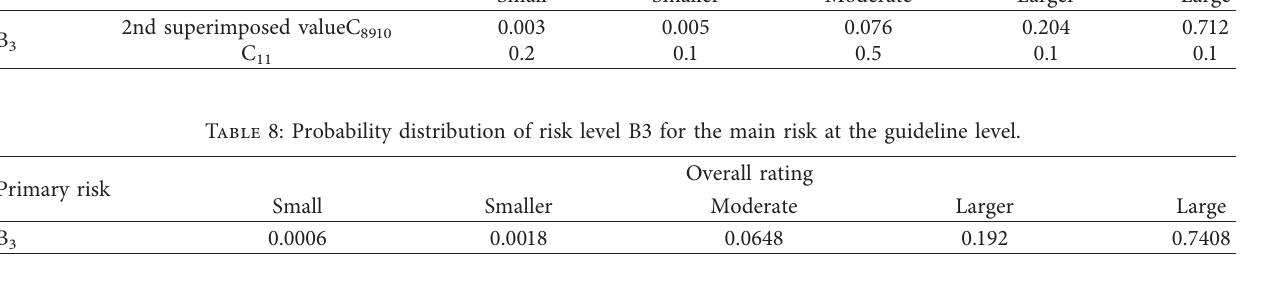
Table 9: Probability distribution of risk levels for master risk at guideline